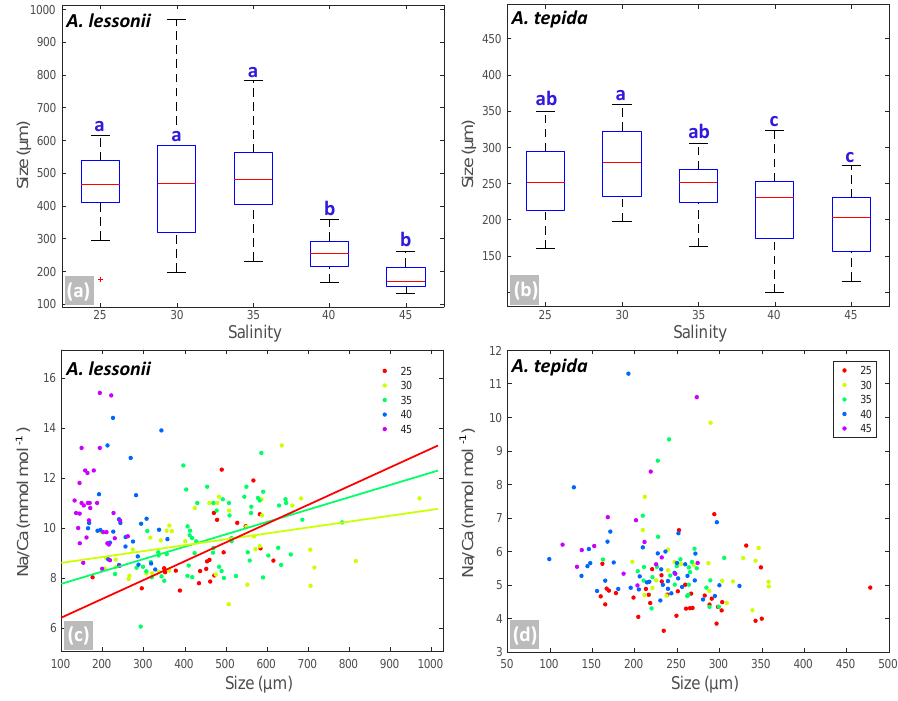
Figure 3. Box plots (a, b) showing the size distributions (median, first and third quartiles, minimum and maximum values) for each salinity condition – n = 24, 40, 60, 27, 33 for A. lessonii and n = 38, 24, 28, 41, 15 for A. tepida . Letters a, b, c indicate significant different population means, based on ANOVA ( p < 0 . 001). Panels (c, d) show the Na / Ca values against size measurements per individual, colour coded per salinity condition (see legend), for A. lessonii and A. tepida. Significant linear regression lines are plotted for A.